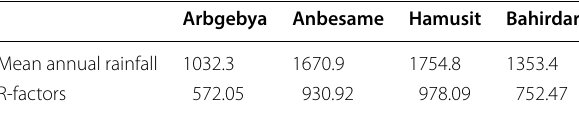
Table 1 Mean annual R-factor values for four